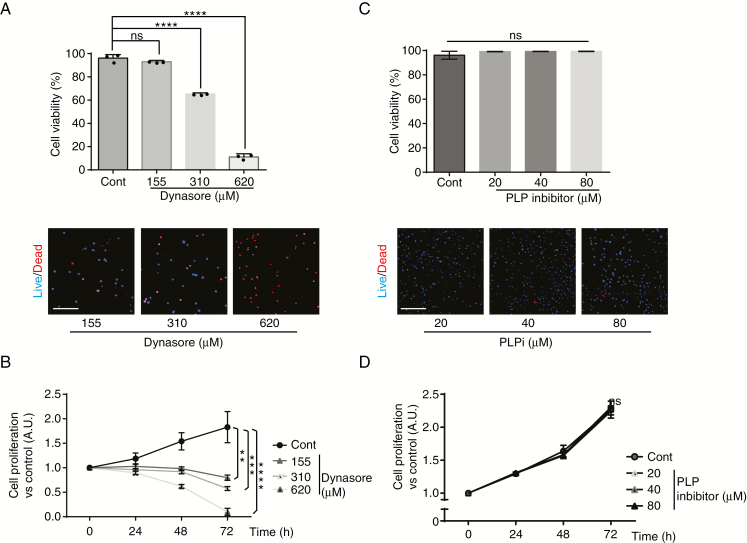
DNM1 inhibitor Dynasore reduces cell viability and proliferation at high doses. (A) Cell viability was recorded in live microscopy with Dead/Live kit (Invitrogen) as represented in lower panels (blue for living cells and red for dead cells). Dynasore was used at 155, 310, or 620 µM as indicated. The graph represents the percentage of living cells at the time of 72 h, and the results as means ± SD of three independent experiments, each done in 10 replicates for each condition. ns, nonsignificant; ****P < .0001 (ANOVA). (B) Cell proliferation was recorded in live microscopy at time 24, 48, and 72 h. Dynasore was used at 155, 310, or 620 µM as indicated. The graph represents cell proliferation at different time points, and the results as means ± SD of three independent experiments, each done in 10 replicates for each condition. ns, nonsignificant; **P < .01; ***P < .001; ****P < .0001 (ANOVA). (C) Cell viability was recorded in live microscopy with Dead/Live kit (Invitrogen) as represented in lower panels (blue for living cells and red for dead cells). PLP1 inhibitor (PLPi) was used at 20, 40, or 80 µM as indicated. The graph represents the percentage of living cells at the time of 72 h, and the results as means ± SD of three independent experiments, each done in 10 replicates for each condition. ns, nonsignificant (ANOVA). (D) Cell proliferation was recorded in live microscopy at time 24, 48, and 72 h. PLP1 inhibitor (PLPi) was used at 20, 40, or 80 µM as indicated. The graph represents cell proliferation at different time points, and the results as means ± SD of three independent experiments, each done in 10 replicates for each condition. ns, nonsignificant (ANOVA).